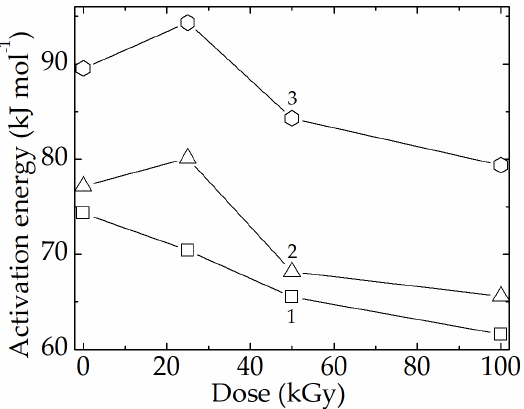
Figure 6. The variation of activation energy for the radiooxidation of polypropylene in the presence of microalgal masses [126]. (1) None; (2) chlorella vulgaris; (3) spirulina platensis.